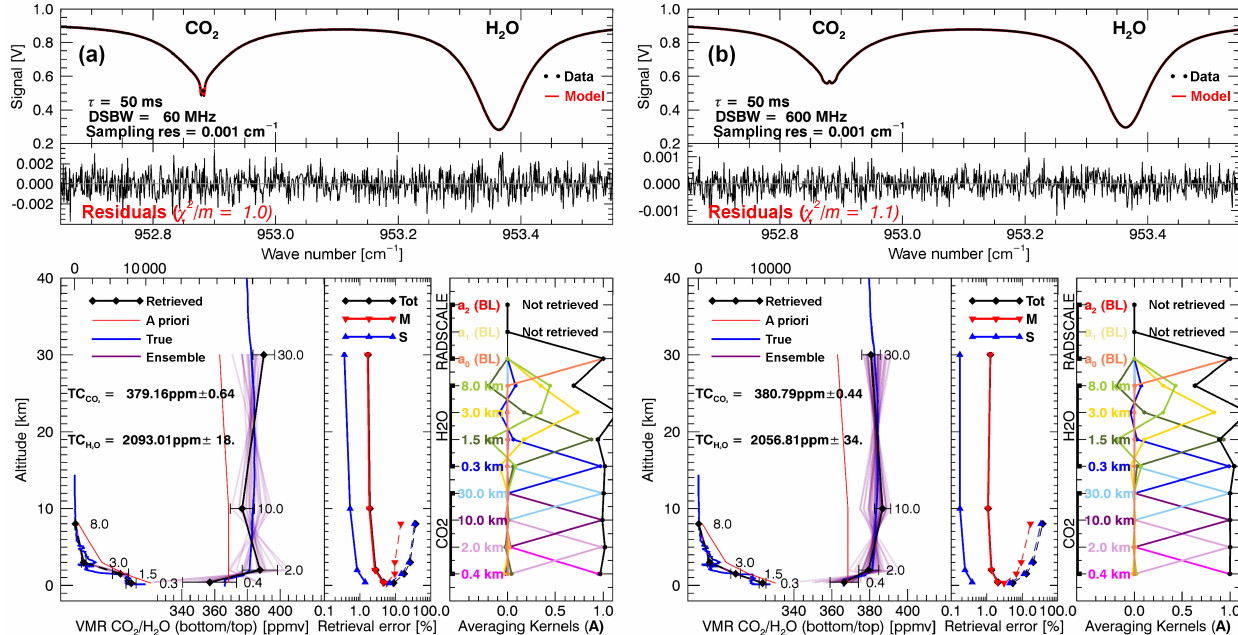
Figure 2. OSS simulation for the selected spectral narrow window under the assumption of a shot-noise-limited operation of the LHR with a 60 ◦ Sun elevation. Instrument spectral resolutions (double side bandwidth, DSBW) are set to (a) 60MHz and (b) 600MHz. The top panel shows a synthetic spectrum (data) with noise, calculated from a known “true” state of the atmosphere. Superimposed is the retrieved spectrum (model), and the difference is shown as residuals below. The bottom panel depicts all (purple) and one selected (black) amongst the retrieved state ensemble members as separate H 2 O and CO 2 profiles, in comparison to the true and a priori state (left). Error bars characterize the retrieval uncertainty at the state vector altitudes. The estimated total columns (TC) with uncertainties are given as text. Total retrieval errors (Tot) and contributions from measurement noise (M) and smoothing error (S) are shown as profiles in the centre. The averaging kernels for the composite state vector are shown on the right; RADSCALE denotes the instrument baseline (BL), which corresponds to a 1 : 1 mapping from radiometric into signal voltage for these